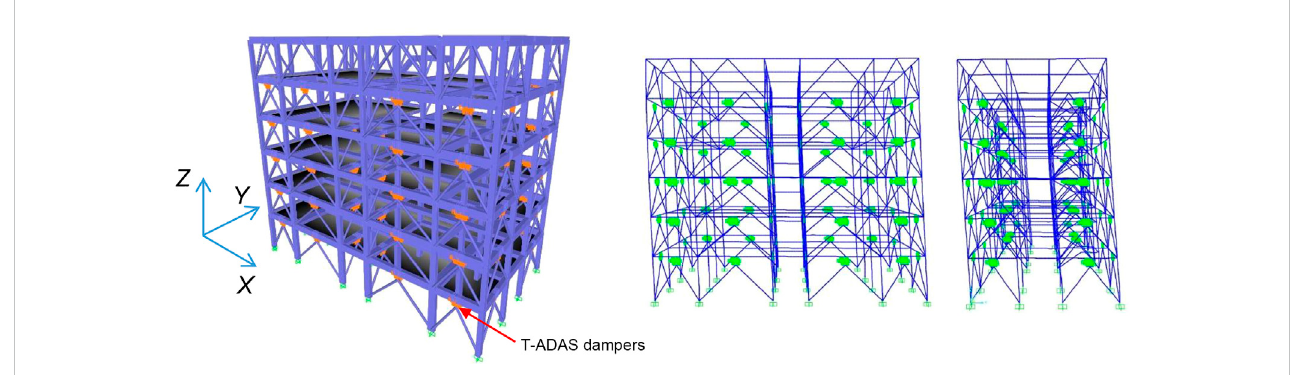
FIGURE 9 Views of the fi nite element model of the structure incorporating the dissipative bracing system and the fi rst mode shapes in X and Y .